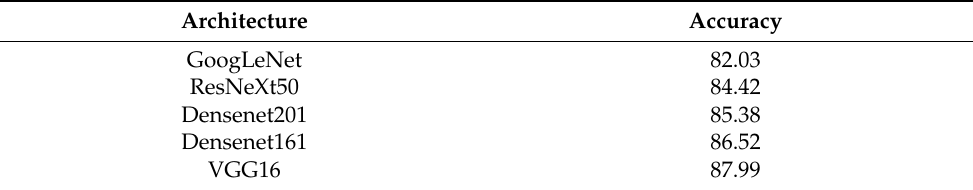
Table 2. Best learning outcomes for architectures on CIFAR10